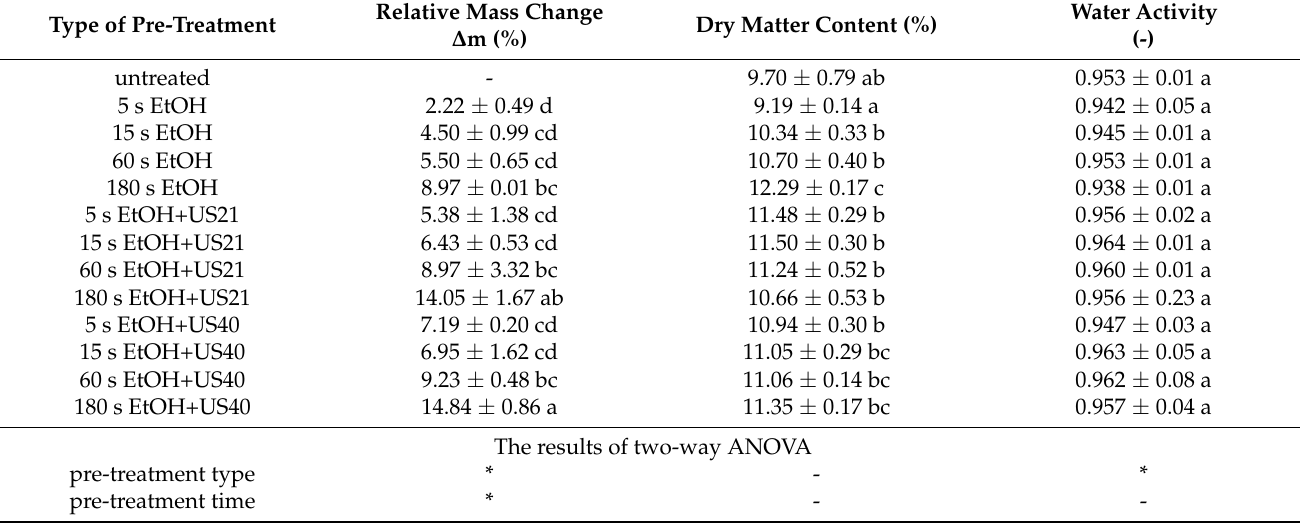
a, b, etc.—different letters in each column indicate different homogeneous groups (one-way ANOVA, α = 0.05). The results of two-way ANOVA indicate the significance (*) or insignificance (-) of the influence of the type and time of treatment ( α =